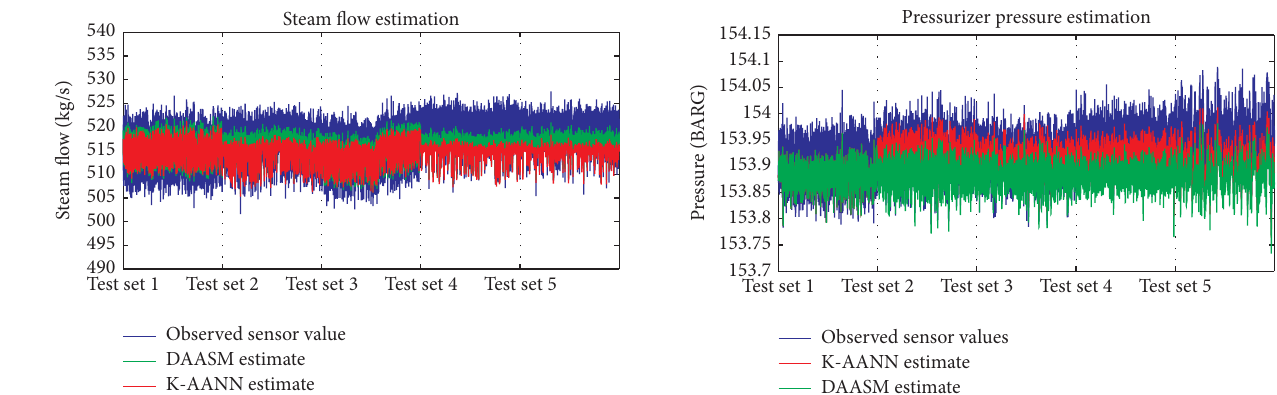
Figure 19: Steam flow estimates against drift failure up to 0.1%.